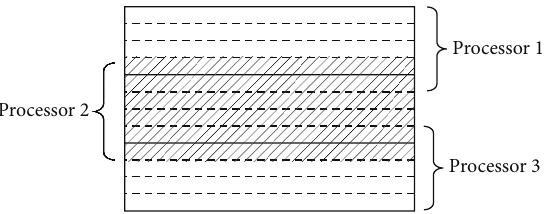
Figure 6: Dust data storage model in three